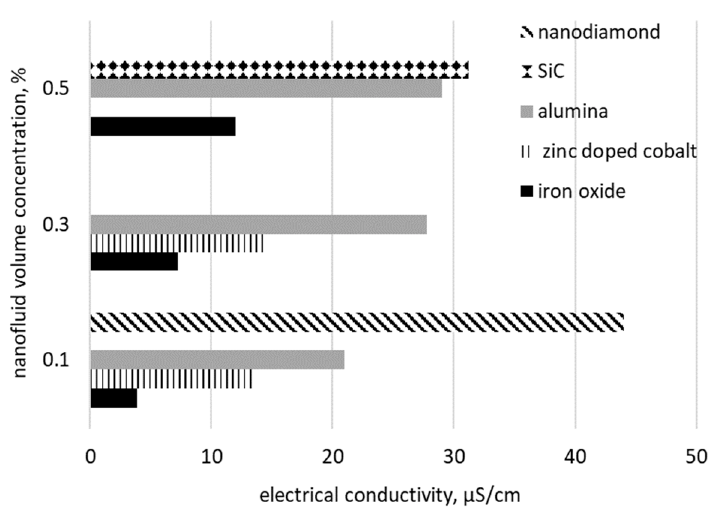
Figure 4. Electrical conductivity for different nanoparticle type [33,34,37,39,41].